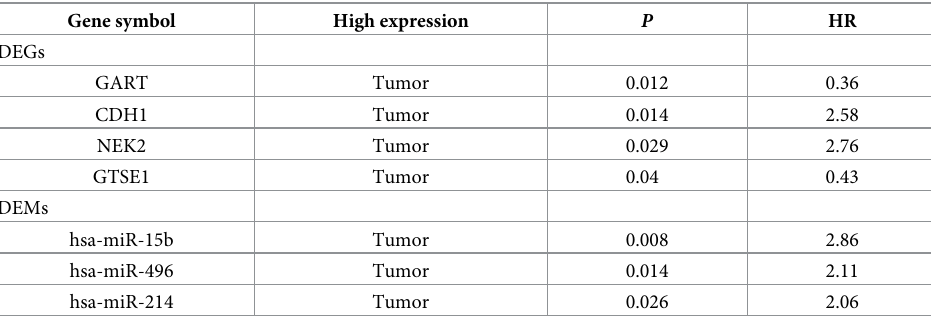
Table 4. The significant DEMs and DEGs related to overall